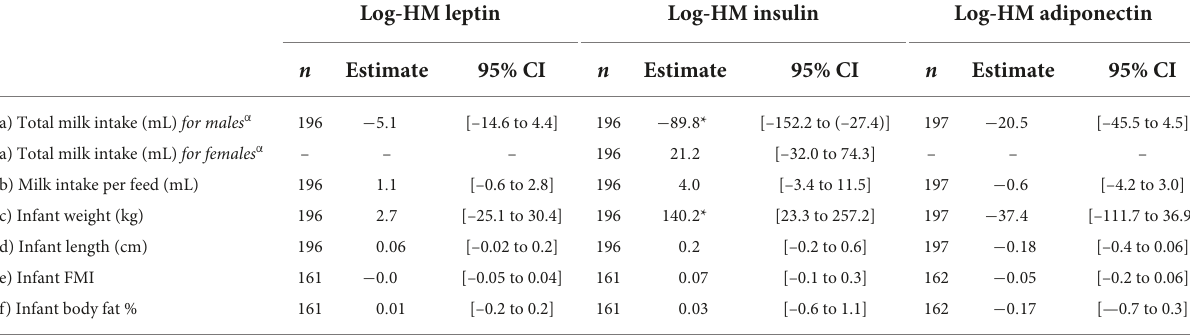
TABLE 4 Initial testing of the total effect (c 1 ) of leptin, insulin and adiponectin concentrations on (a) total milk intake, (b) milk intake per feed, (c) infant weight, (d) length, (e) fat mass index and (f) body fat percentage,